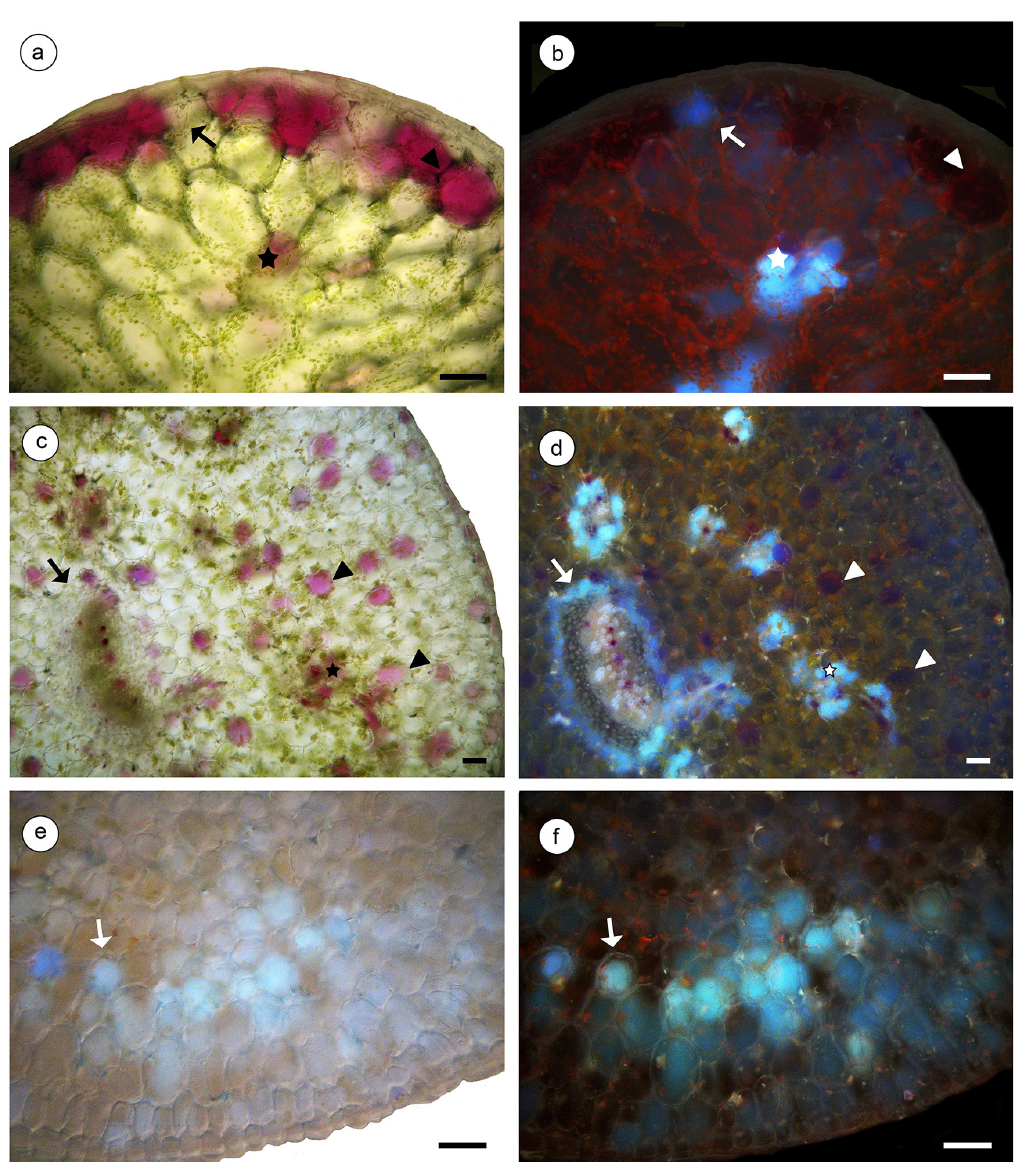
Fig. 5: Cross sections of Kalanchoe fedtschenkoi leaves. a - b – margin of the leaf blade at the middle third (control): visible light (a); UV light (b). c - f – petiole in median region: adaxial side and main vascular bundle (c, d); abaxial side (e, f); visible light (c); UV light (d, f); overlap of visible light and UV light (e); anthocyanic idioblasts with pink color under white light and with blue fluorescence under UV (stars); anthocyanic idioblasts with pink color under white light and without fluorescence under UV (arrow heads); blue fluorescent cells (arrows). Bars 100